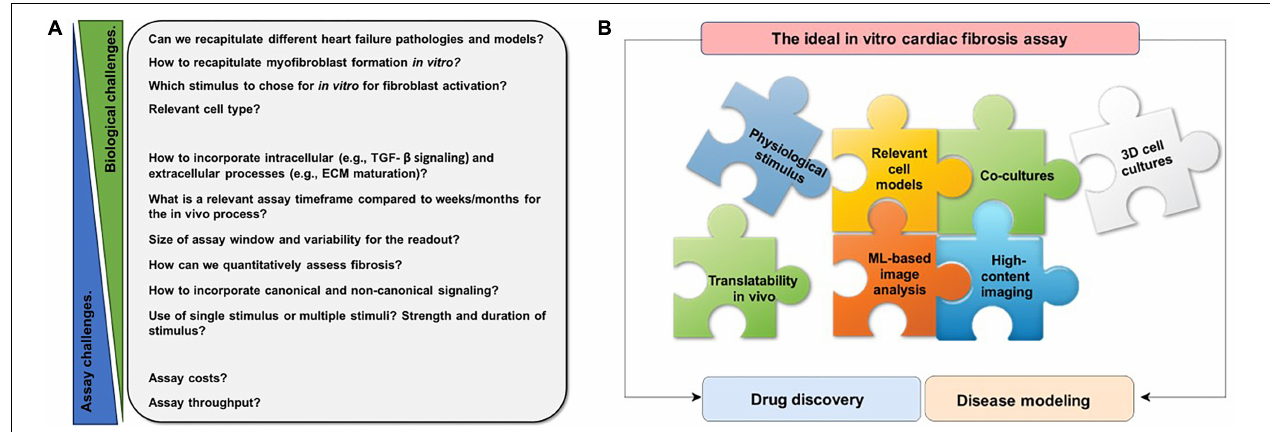
FIGURE 1 | Schematic overview of challenges of recapitulating cardiac fibrosis in vitro and features of an ideal in vitro cardiac fibrosis assay. (A) Numerous challenges have to be overcome to recapitulate the complex, multistep process of cardiac fibrosis in vitro . These are challenges of fibroblast biology, challenges in assay development, or in between. (B) Each puzzle piece represents a feature that should be taken into account for the ideal in vitro cardiac fibrosis assay. Many different aspects, such as physiological stimulus, relevant cell models, cocultures, three-dimensional (3D) cell culture, high-content imaging, machine learning (ML)-based analysis, translatability to in vivo , and need to be considered for a physiologically relevant in vitro cardiac fibrosis